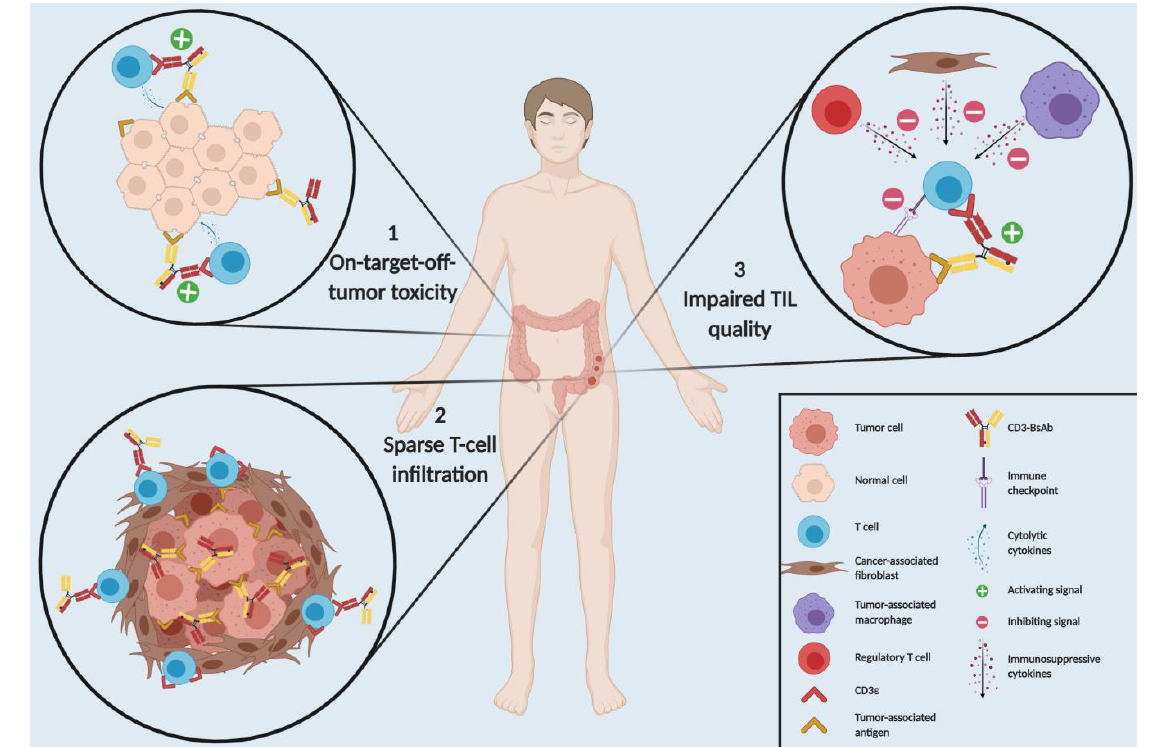
Figure 1. Three main hurdles for CD3-BsAb therapy in solid tumors. ( 1 ) CD3-BsAbs can generate on-target off-tumor toxicities by binding with the TAA arm to the same antigen on healthy cells, thereby redirecting T cells towards normal tissues, resulting in permanent tissue destruction. ( 2 ) Certain types of solid tumors (“immune desert” and “immune-excluded”) have sparse or even no T-cell infiltration, thereby preventing CD3-BsAb from cross-linking T cells to tumor cells, resulting in limited treatment efficacy. ( 3 ) The tumor microenvironment (TME) of solid tumors contains multiple immunosuppressive cell types, including cancer-associated fibroblasts, regulatory T cells and tumor-associated macrophages, thereby hampering the quality of effector T cells. Furthermore, immune checkpoints further decrease tumor-infiltrating lymphocyte (TIL) effector functions.